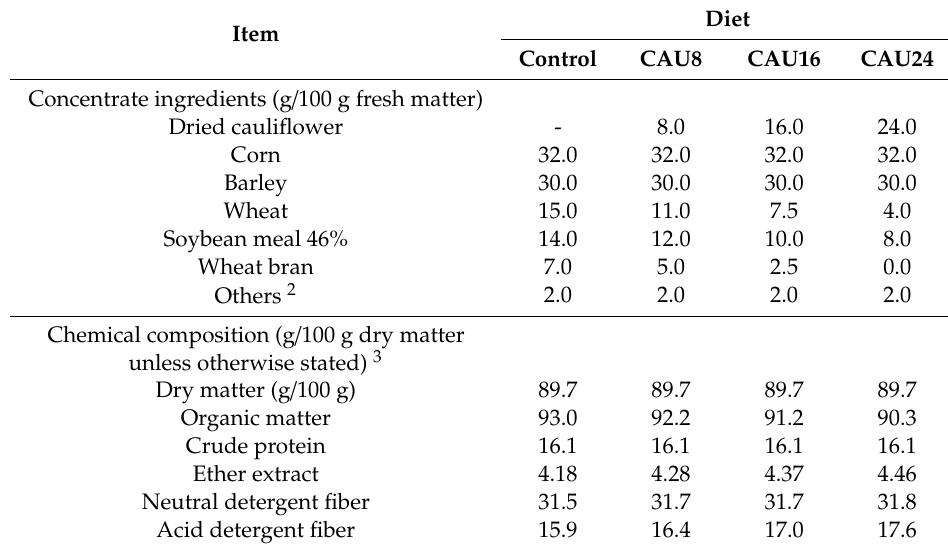
Table 5. Concentrate ingredients and the chemical composition of experimental diets containing increased amounts of cauliflower (CAU) used in Experiment 2 1